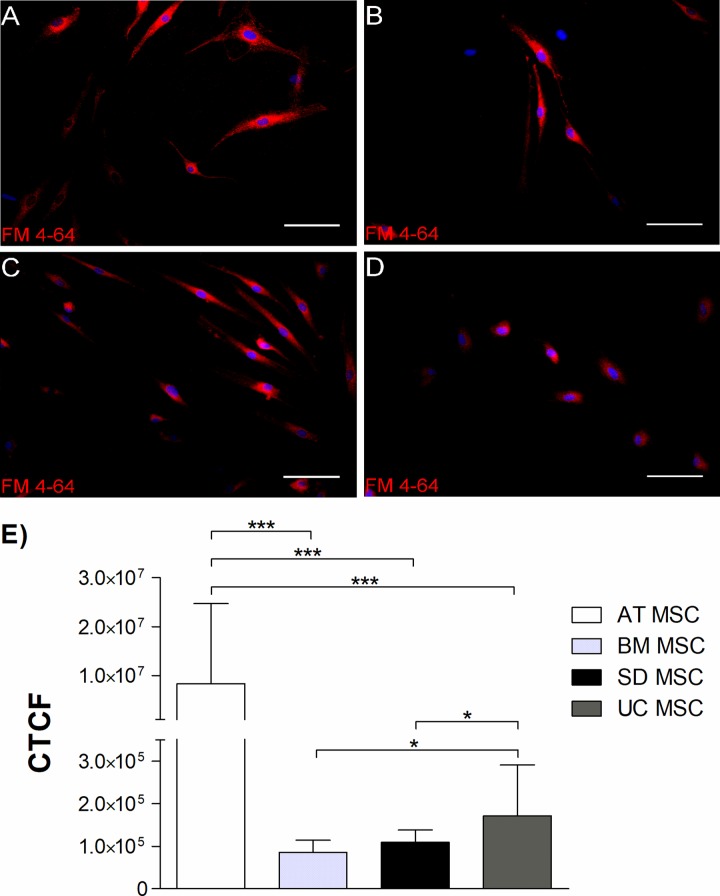
Synaptic vesicle staining after 18 days of neural
differentiation.FM 4–64 dye was positive in neural-induced MSC. (A) AT-MSC, (B)
BM-MSC, (C) SD-MSC, (D) UC-MSC. Nestin marker expression (green) and
nuclei (Blue), Scale bar 100 μm. (E) Corrected Total Cell
Fluorescence (CTCF), Data represents means ± SEM of 3 separate
experiments. ns P> 0.05, * P <0.05, ** P <0.01, *** P
<0.001.